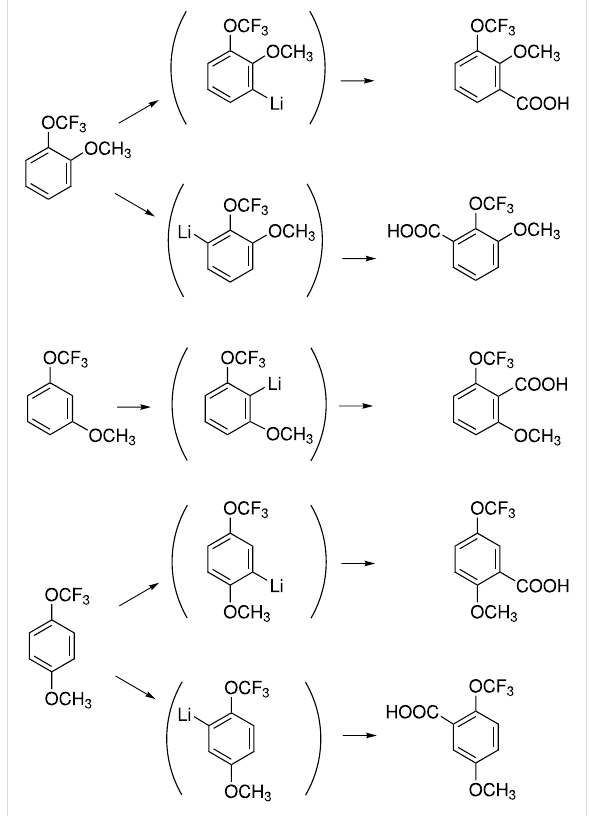
Scheme 17: Metalation of